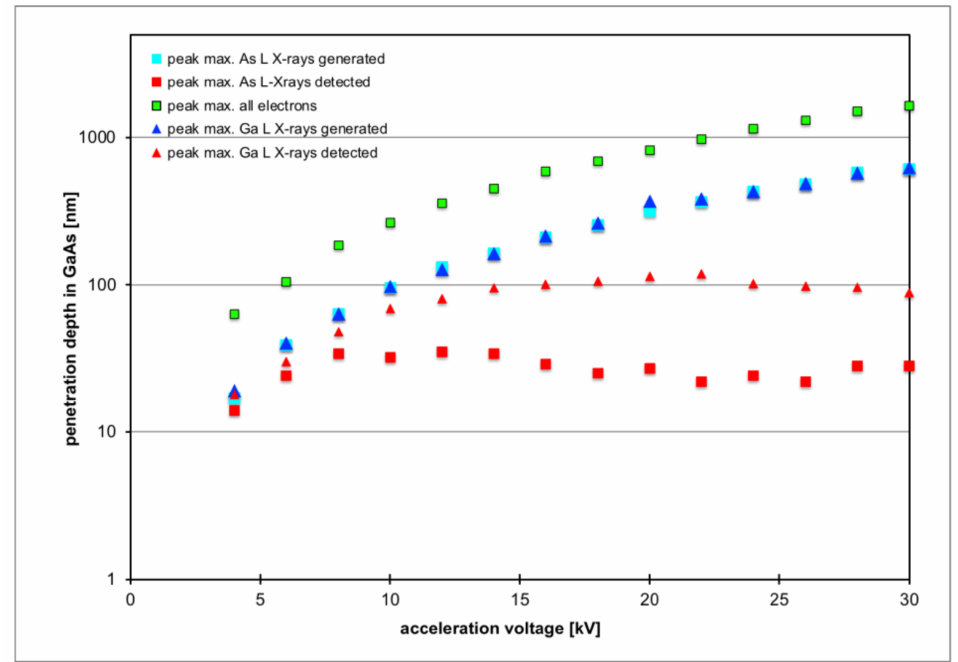
Figure 2. Monte Carlo simulation of the peak positions of the depth distributions of electrons (green squares), As L-line X-rays (turquoise and red squares) and Ga L-line X-rays (blue and red triangles) in GaAs as function of electron acceleration